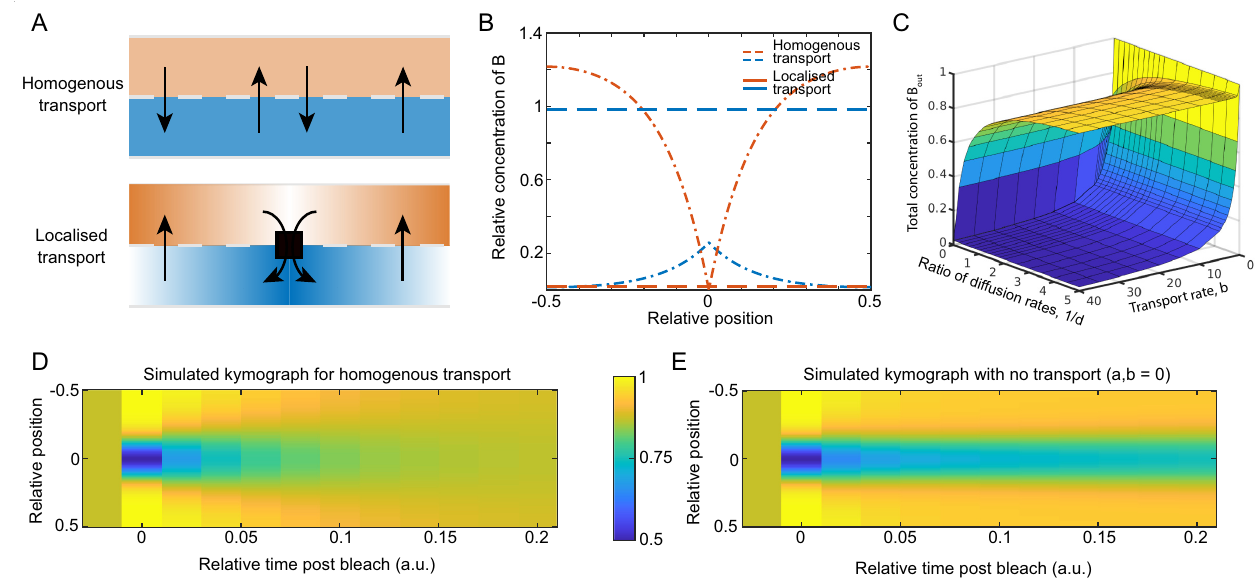
Fig 2. Localised transport is less efficient than homogenous transport. (A) We compare two schemes for protein transport from the outer to inner periplasm: spatially uniformly across the length of the cell (homogeneous transport; top) and only at the centre of the cell (localised transport; bottom). In both cases the transport in the opposite direction, from inner to outer, is spatially uniform. Here, the blue and orange distinguish the inner and outer periplasm respectively. (B) Example line profiles of the concentration in the inner (blue) and outer (orange) periplasm for homogenous transport (dashed) and localised (dot-dashed) transport. The average transport rate is the same in both cases. Only the localisation of the transport differs. Note that there is more protein in the outer periplasm for localised transport. (C) A surface plot showing the total concentration of B out ( x , t ), in the case of homogenous transport (lower surface) and localised transport (upper surface), as the dimensionless parameters d = D / D and b = β 0 / α L are varied. Here a = α L 2 / D . The parameters in (B) are a = 50, out in in b = 100, and d = 0.2. See also S2 Fig. (D) Kymographs of simulated FRAP experiments with (left) and without (right) homogeneous transport. Both cases have the same steady state with the same concentration of molecules in the inner and outer periplasm. Note that the kymograph with transport returns to the initial steady state faster, showing how the transport-induced reshuffling of the slower sub-population increases the effective rate of diffusion of the entire population. Note that the system with no transport will eventually return to the initial steady state. In both kymographs d = 0.02, and with homogenous transport a = 50, and b = 1.